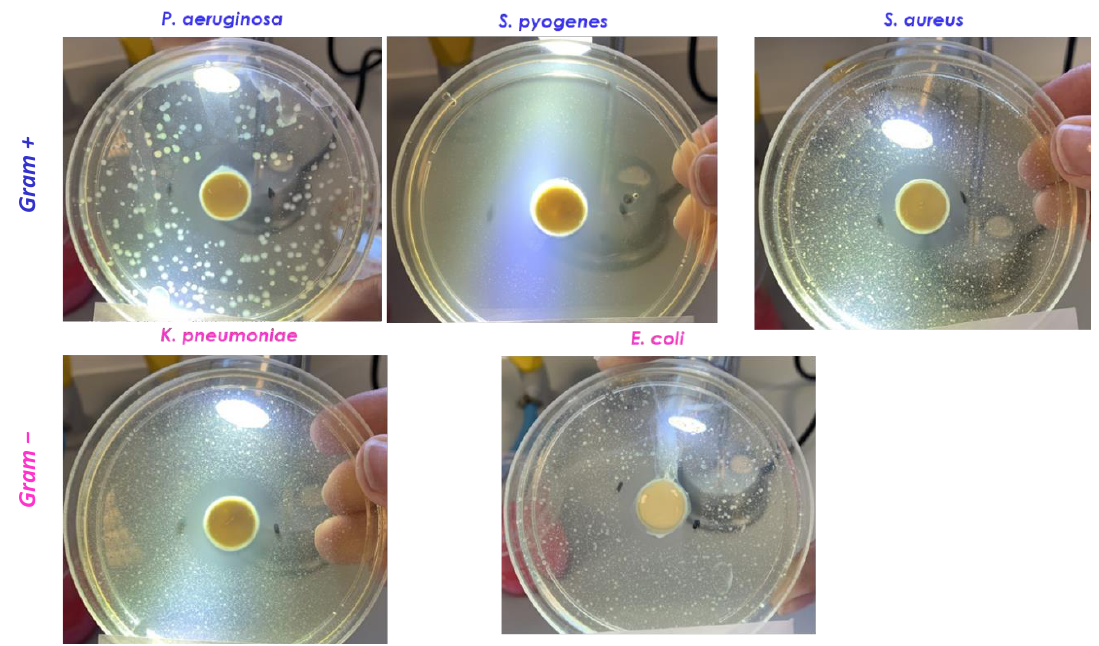
Figure 14. Inhibition halos measured for the emulgel.